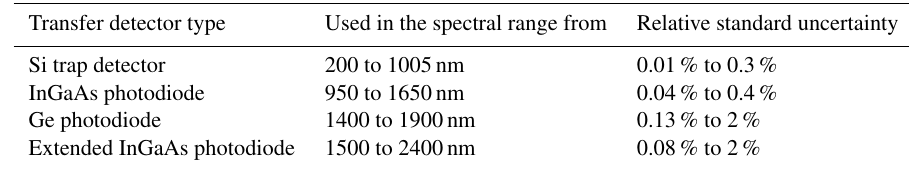
Table 1. Transfer detectors in the UV, VIS and NIR and typical relative standard uncertainties of the spectral responsivity realized at the PTB (Hartmann et al., 2010; Meindl et al., 2006; Noulkow et al., 2009; Werner et al., 2000, 2014).